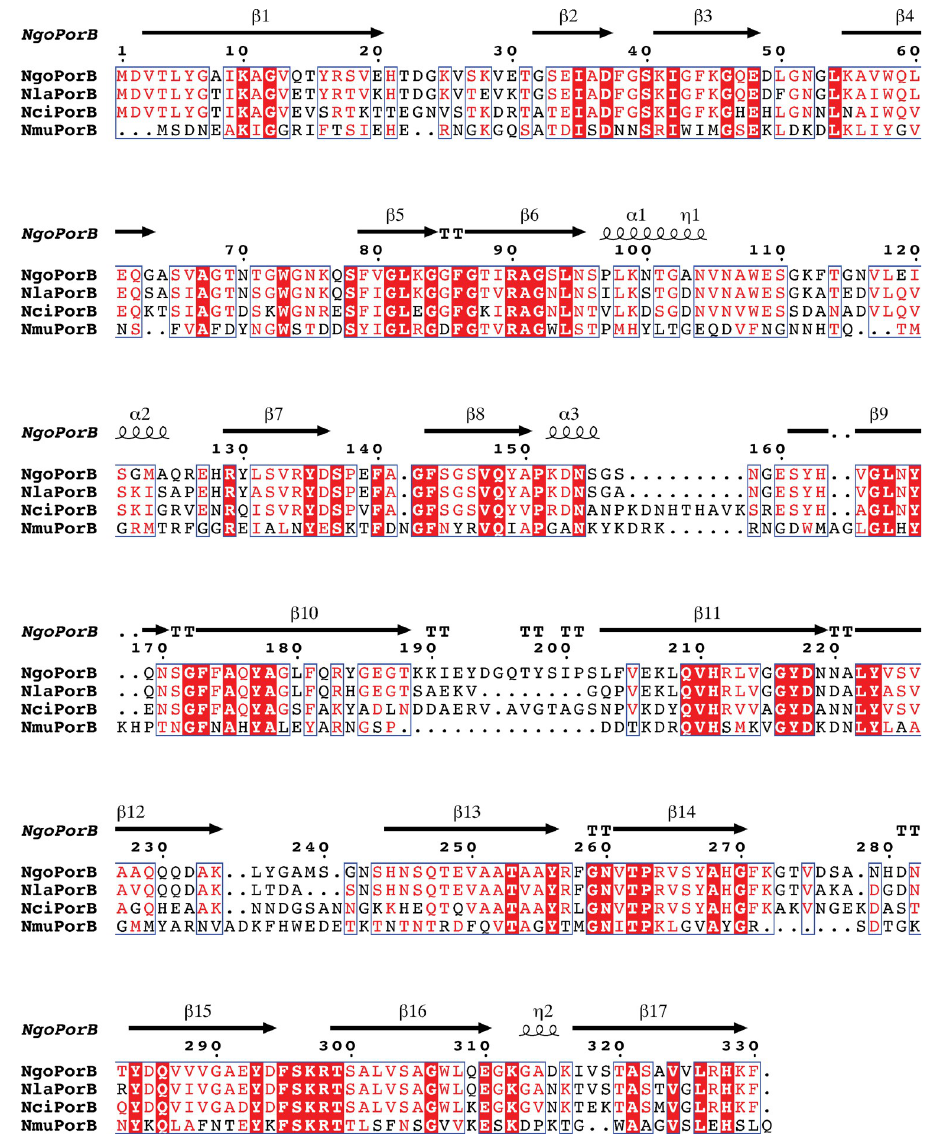
Fig 6. Amino acid sequence alignment of the PorB homologs from N . gonorrhoeae , N . lactamica , N . cinerea , and N . mucosa . Each of the four Neisseria genomes examined encode a PorB homolog. An alignment depicting the homology between PorB at the primary amino acid sequence structure from four species of Neisseria is shown. Amino acids identical among the four PorB homologs are shown in a dark red box. Amino acids corresponding to the beta- barrel regions of PorB using N . meningitidis PorB as a structure model are indicated as arrows above the sequence, alpha helical segments are denoted with a helix above the sequence, and the regions marked with T represent turns. This figure was prepared using ESPript 3.0 (https://espript.ibcp.fr/ESPript/cgi-bin/ESPript.cgi) [41].